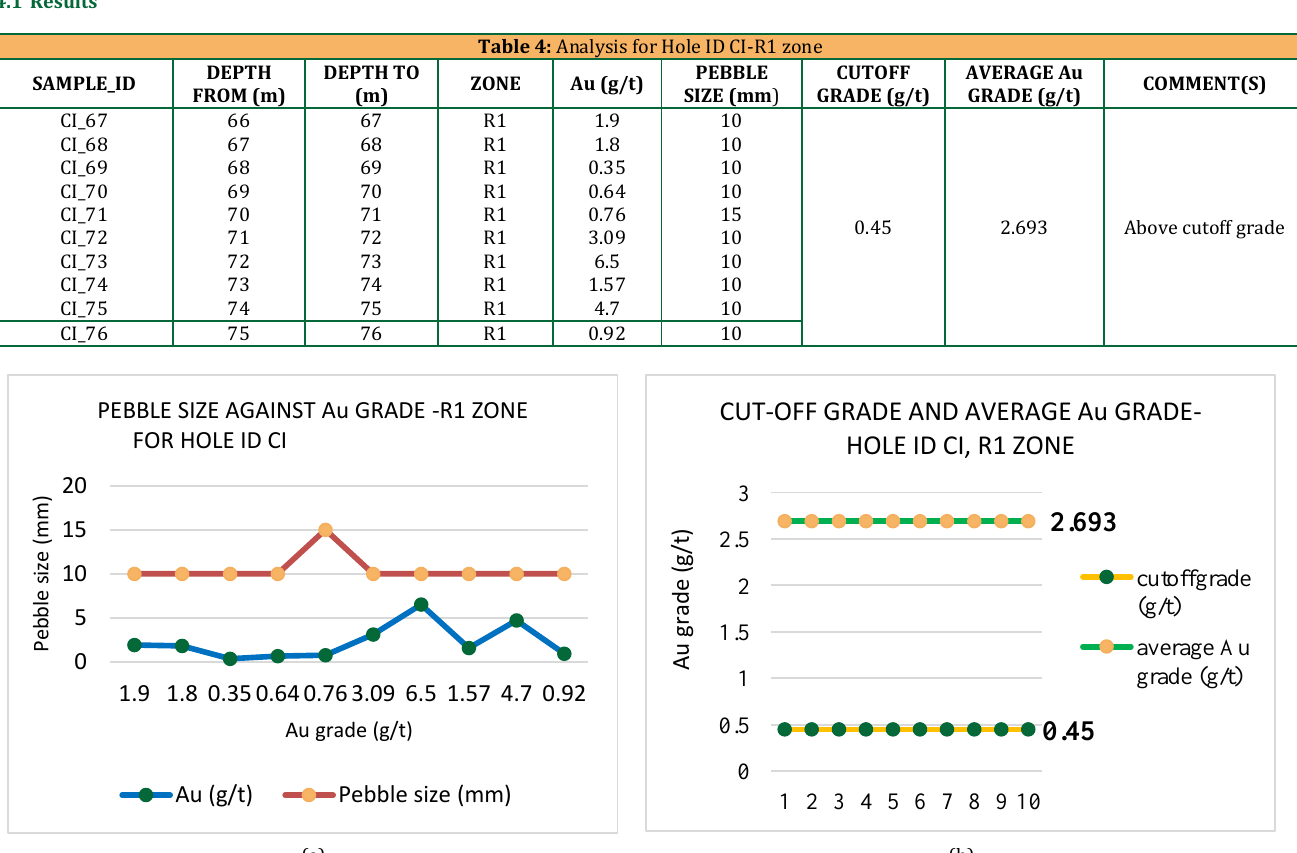
Table 4: Analysis for Hole ID CI-R1 zone